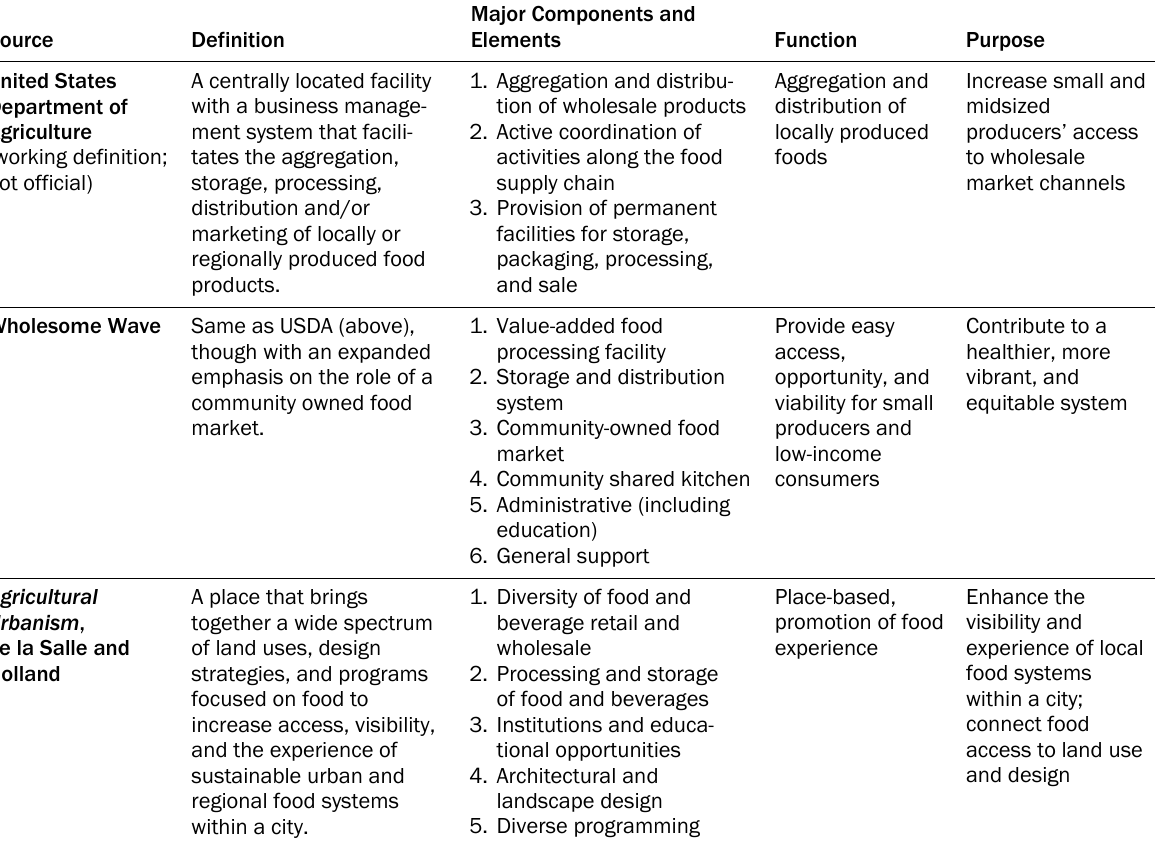
Table 1. Summary of Three Common Food Hub